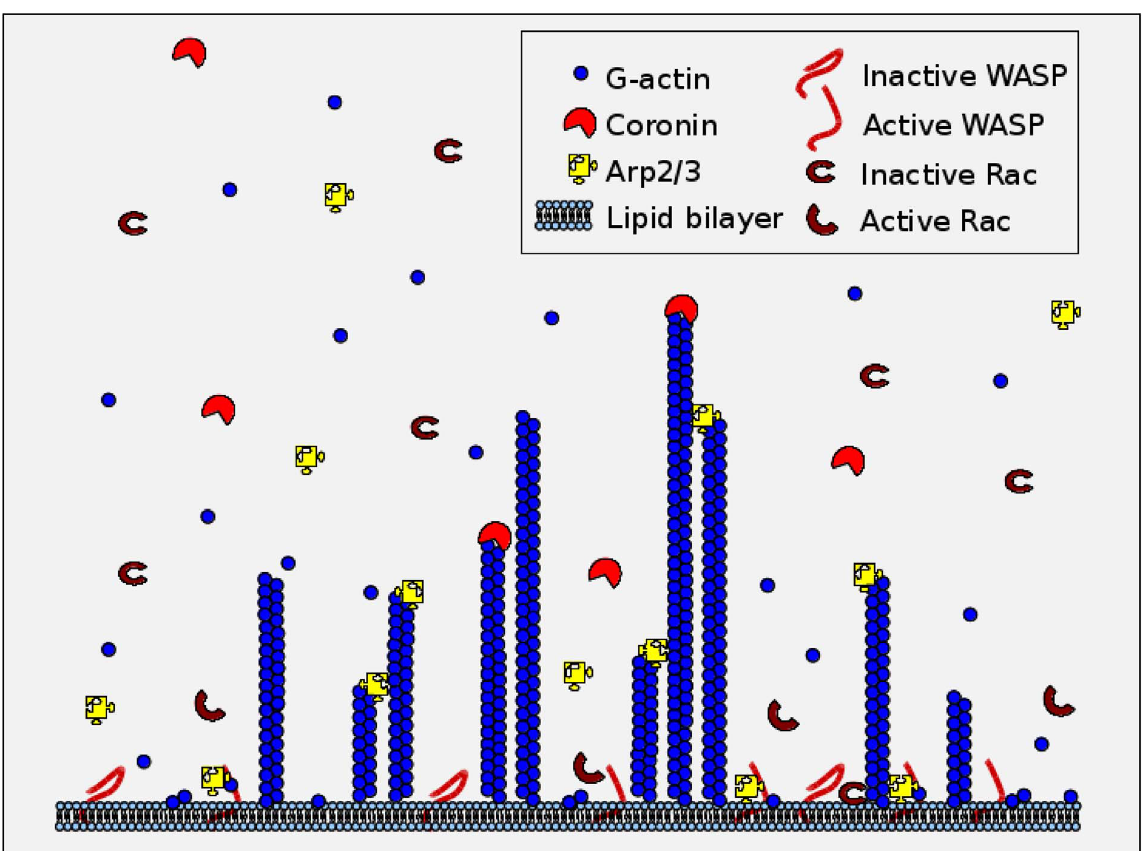
Figure 4. A schematic of the network structure and molecular interactions in the model.